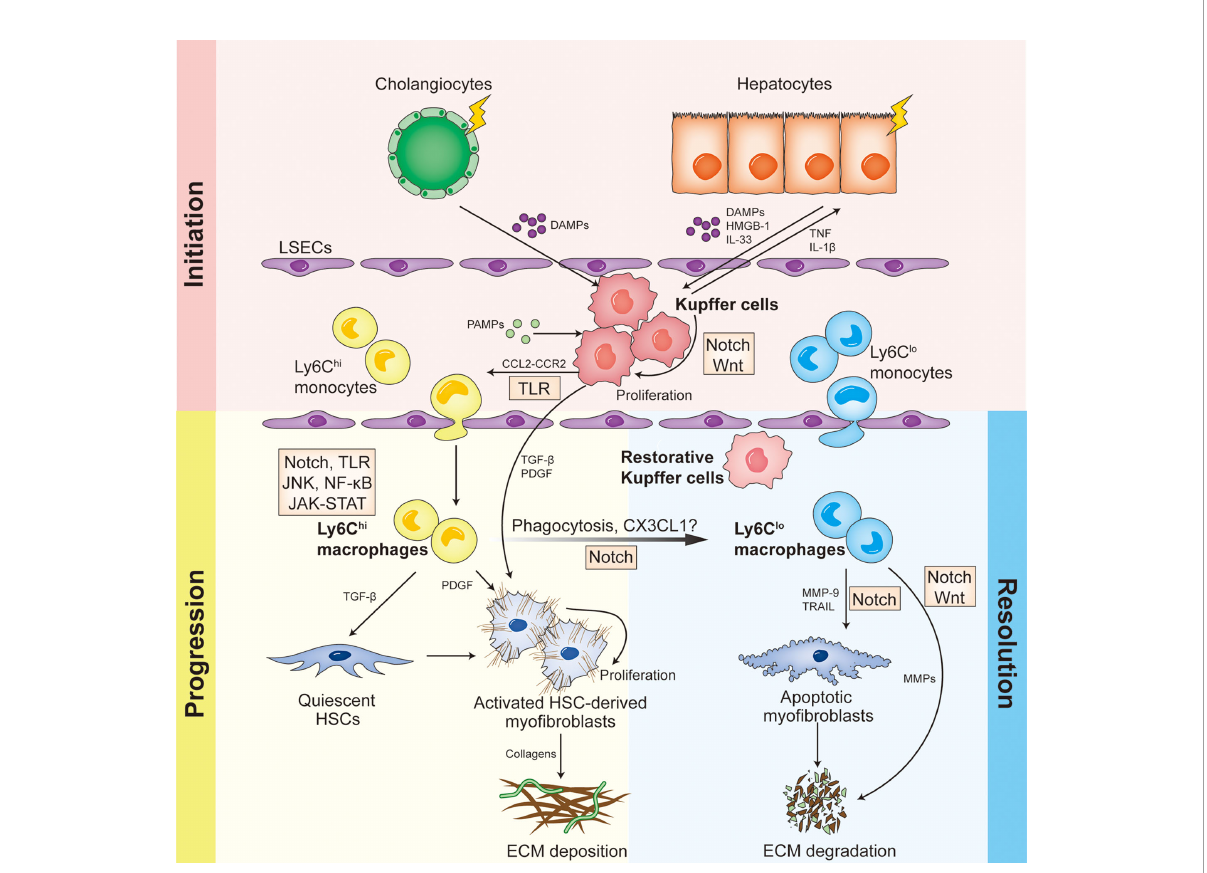
FIGURE 1 Different hepatic macrophage subsets function differently in distinct stages of liver fi brosis, and are modulated by various signaling pathways and regulatory